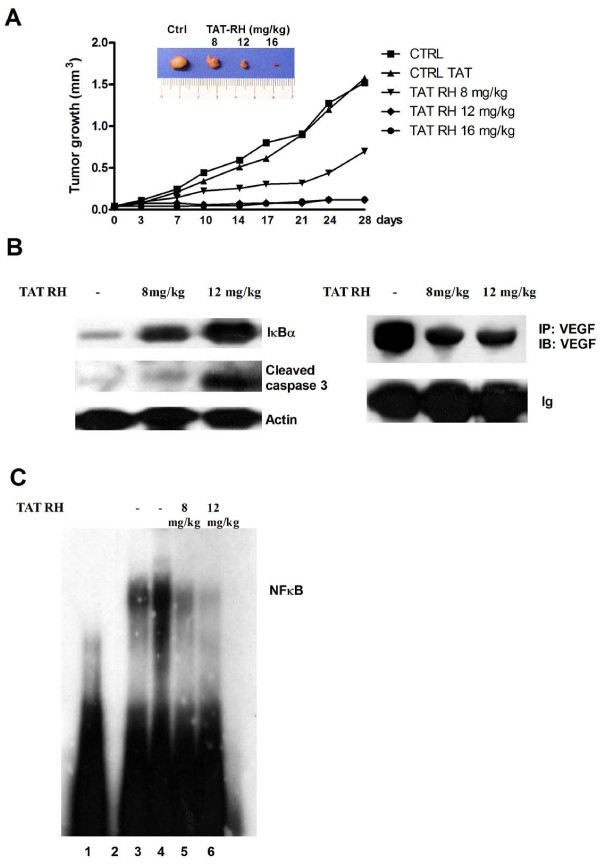
Effects of TAT-RH in vivo on tumor growth and biochemical analysis. A) We evaluated the effects of TAT-RH on tumor growth in BALB/c nude mice. High doses (16 mg/kg in 200 μl) lead to regression of tumors, intermediate doses (12 mg/kg in 200 μl) are able to completely inhibit tumor growth and low doses (8 mg/kg in 200 μl) can only delay tumor growth. Figure also shows a representative image of tumors at the end of the treatment (inset). B) Tumors were homogenized and the biological effects of TAT-RH treatment were evaluated by WB. TAT-RH leads to a dose-dependent increase of IκBα and cleaved caspase 3 and a reduction of VEGF levels. TAT treated tumors were used as controls. C) To evaluate the effect of TAT-RH on NFκB activity, we performed an EMSA using nuclear extracts from tumors. TAT-RH treatment reduces NFκB activity. Lane 1 = probe alone; Lane 2 = empty; Lane 3-4 = TAT treated tumors; Lane 5-6 = TAT-RH treated tumors.